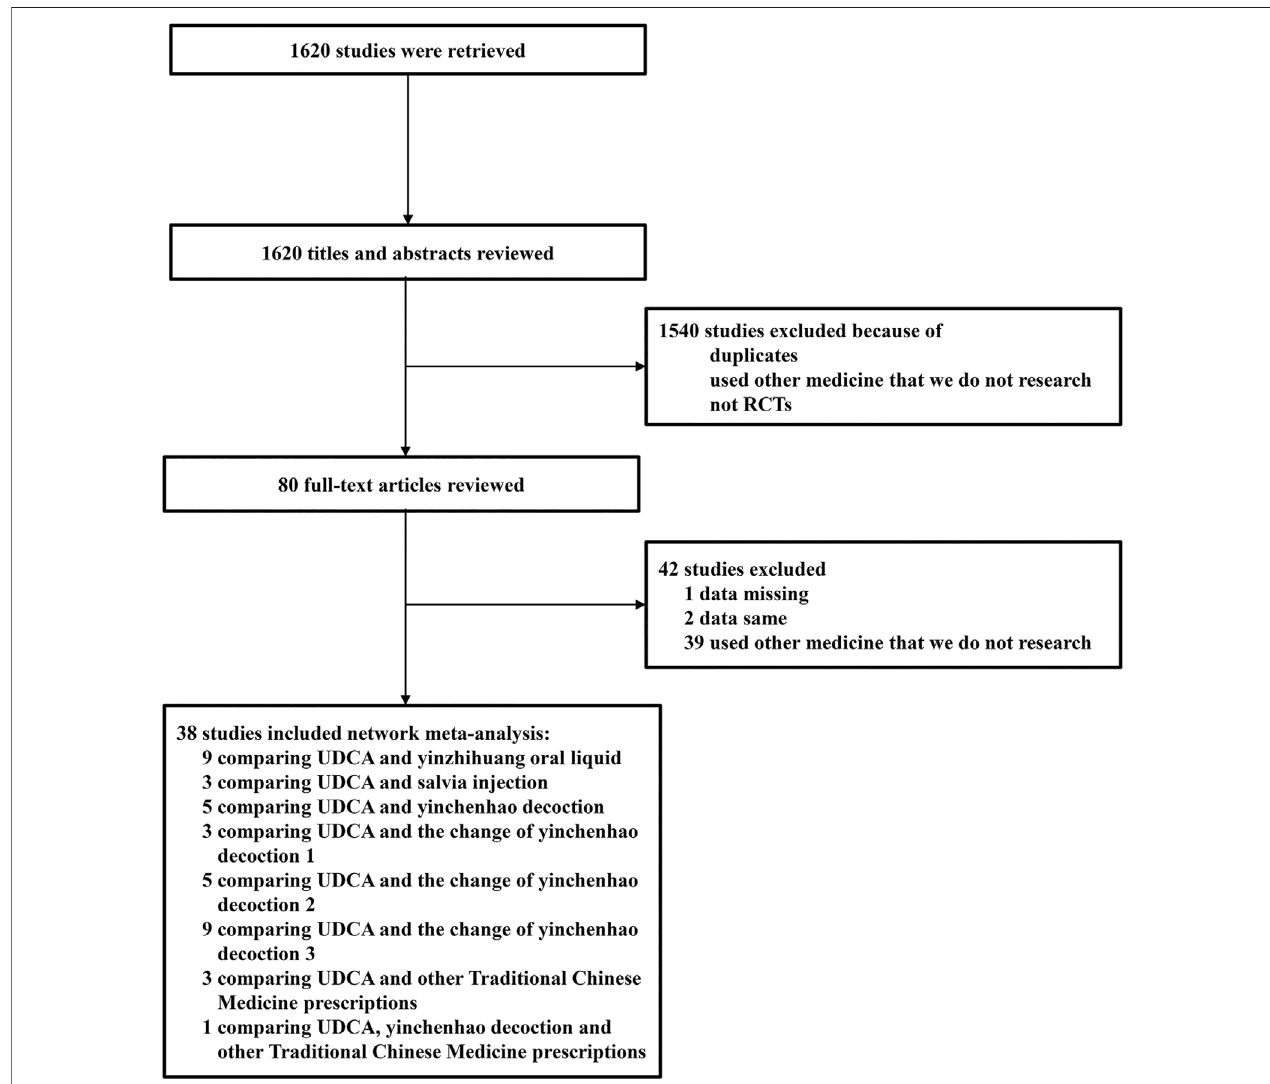
FIGURE 1 | Flow chart of study